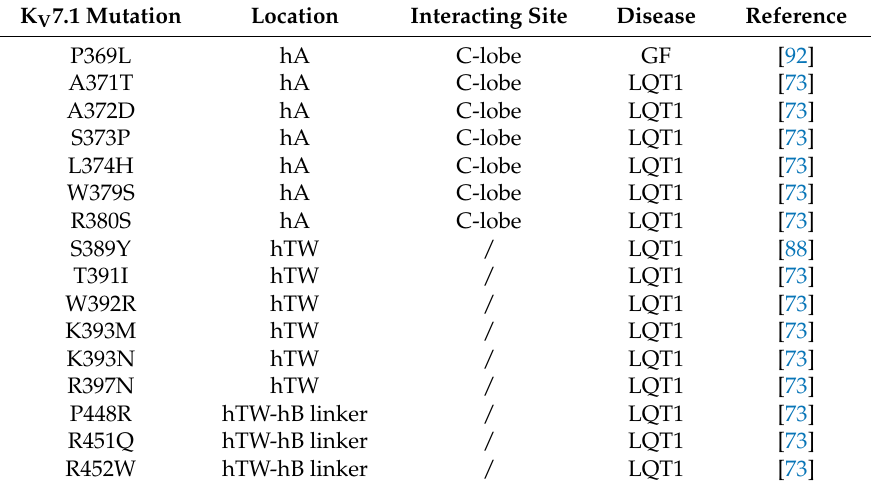
Table 2. Mutations in K V 7.1 channels influencing CaM binding. GF: gingival fibromatosis; LQT1: